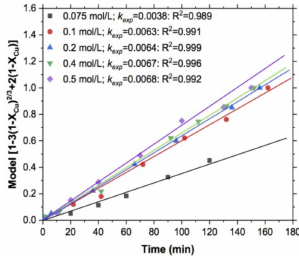
Figure 4. Determination of k exp , model of shrinking core, and diffusive control: effect of thiosulfate